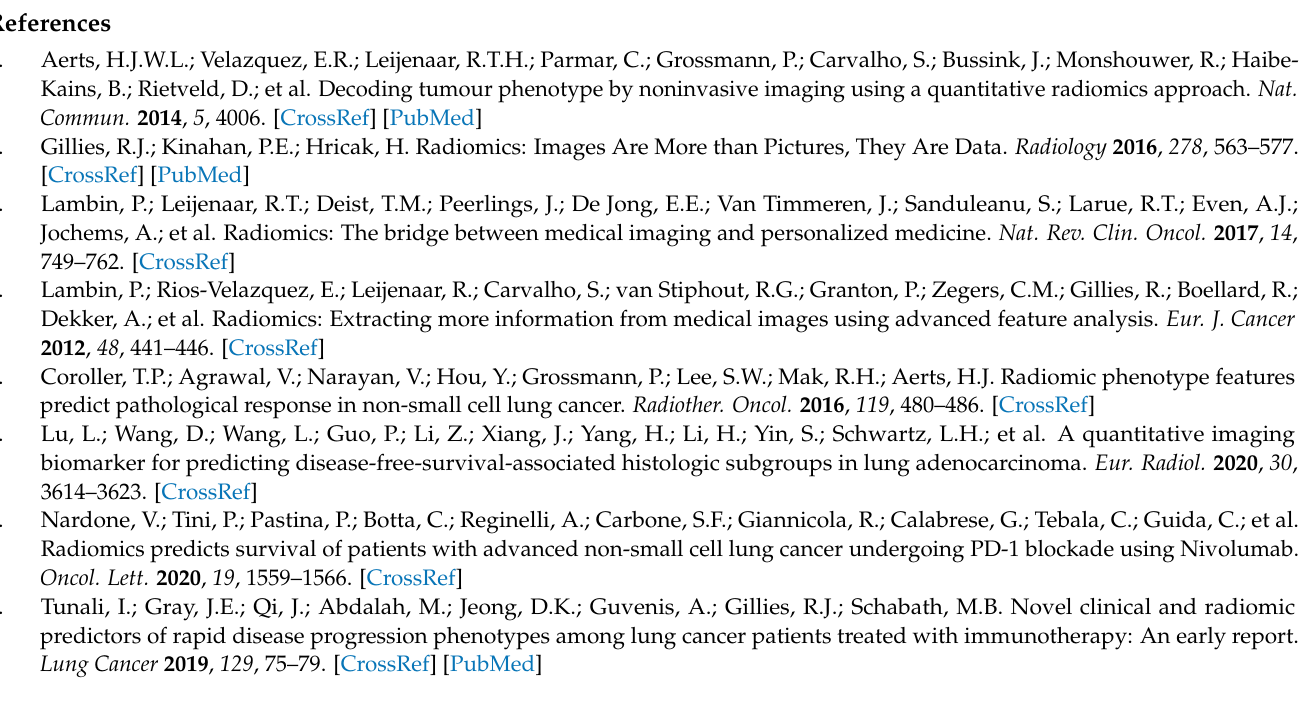
development cohort, Table S2: CT image scanner parameters for the validation cohort, Table S3: A summary table for features groups analyzed in the development cohort, Table S4: CCC heatmap for the development cohort with CCC